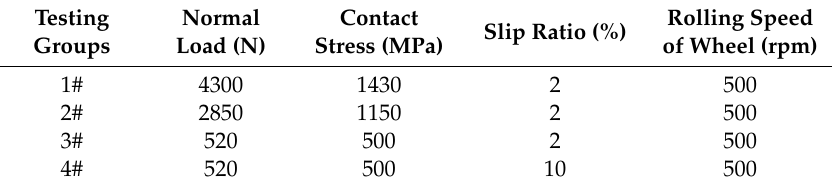
Table 3. Summary of experimental parameters.